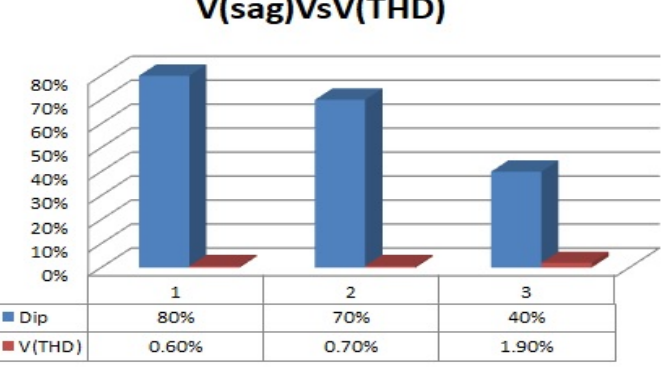
Figure 10. Voltage THD of induction motor under loaded conditions [neutral connected].